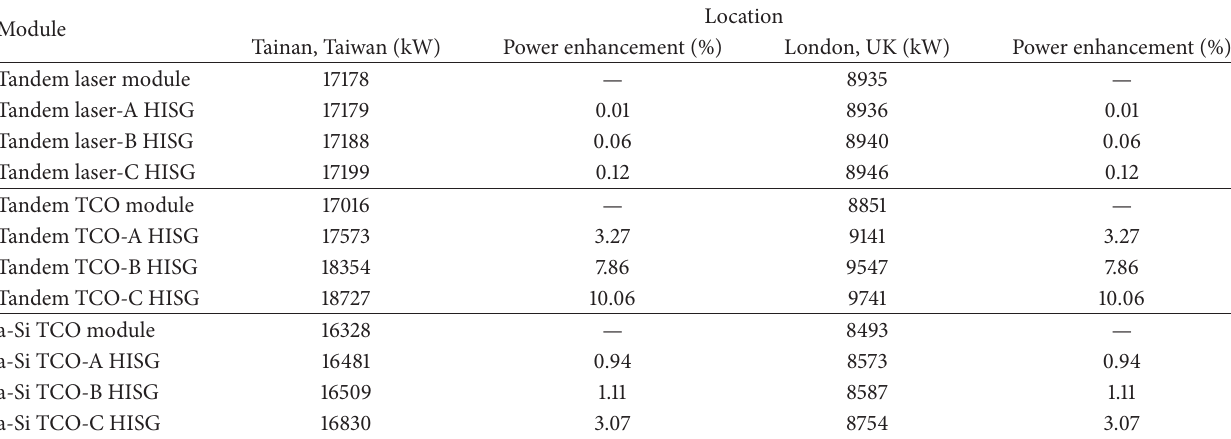
Table 7: Power generation results for building body simulations.